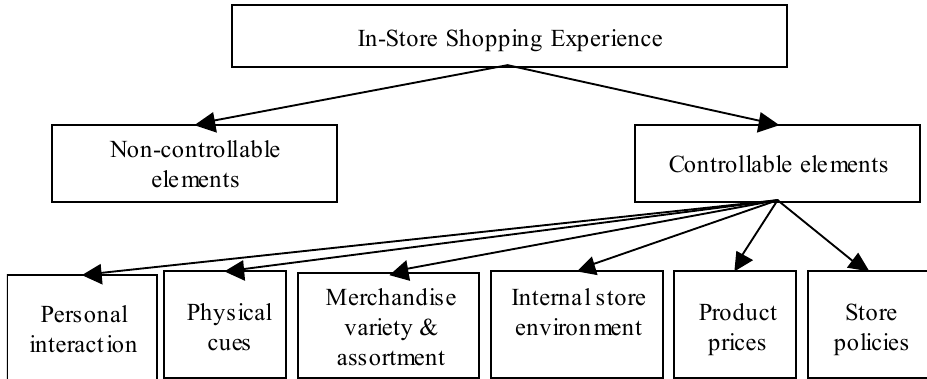
Figure 2: Schematic presentation of the dimensions of the ISE tested in the second phase of the study